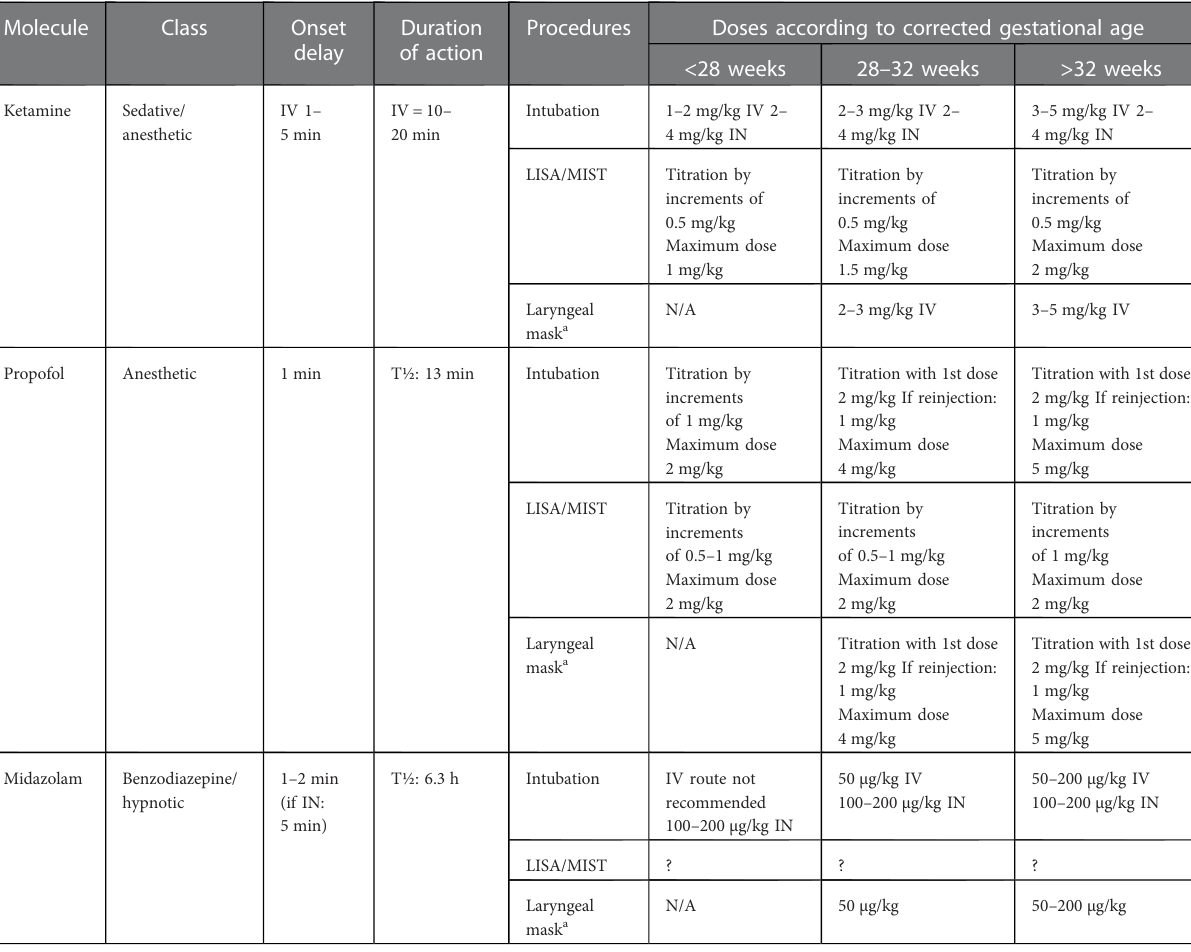
TABLE 4 Proposed doses for possible sedatives and anesthetics for premedication before